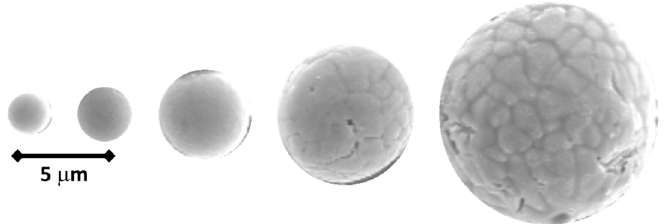
Figure 23. SEM micrographs of gas-atomized Al 6061 particles (to scale) depicting the microstructural variation function of the powder particle size. SEM micrographs corroborate the experimentally observed amorphous structure at particle sizes that are at least less than 10 µ m, and generally less than 5 µ m, in Figure